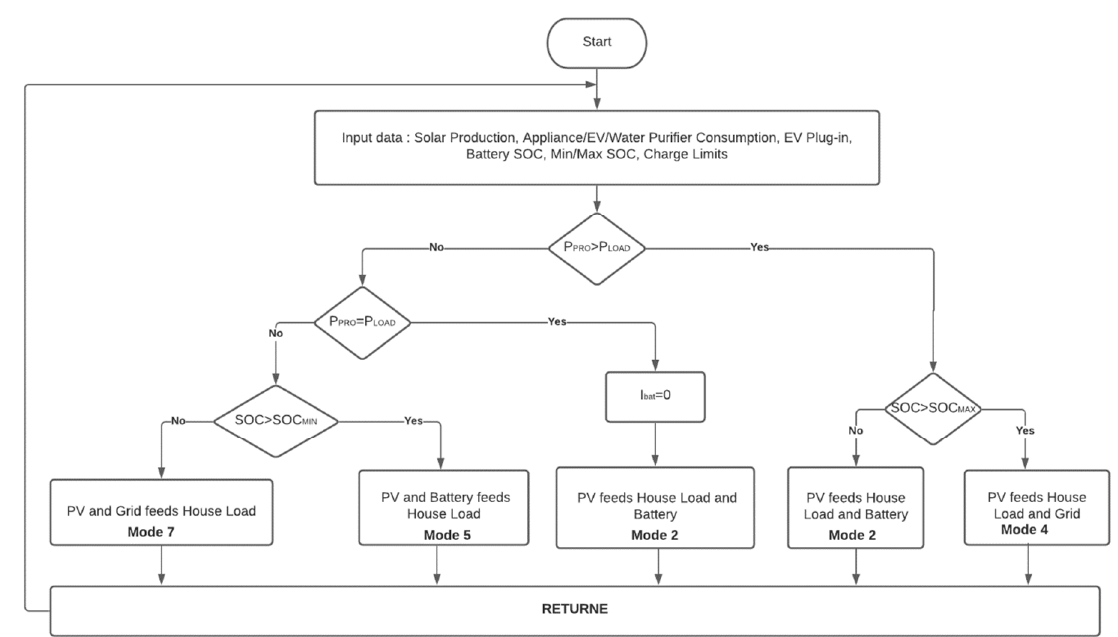
Figure 7. Flowchart of the basic control algorithm.